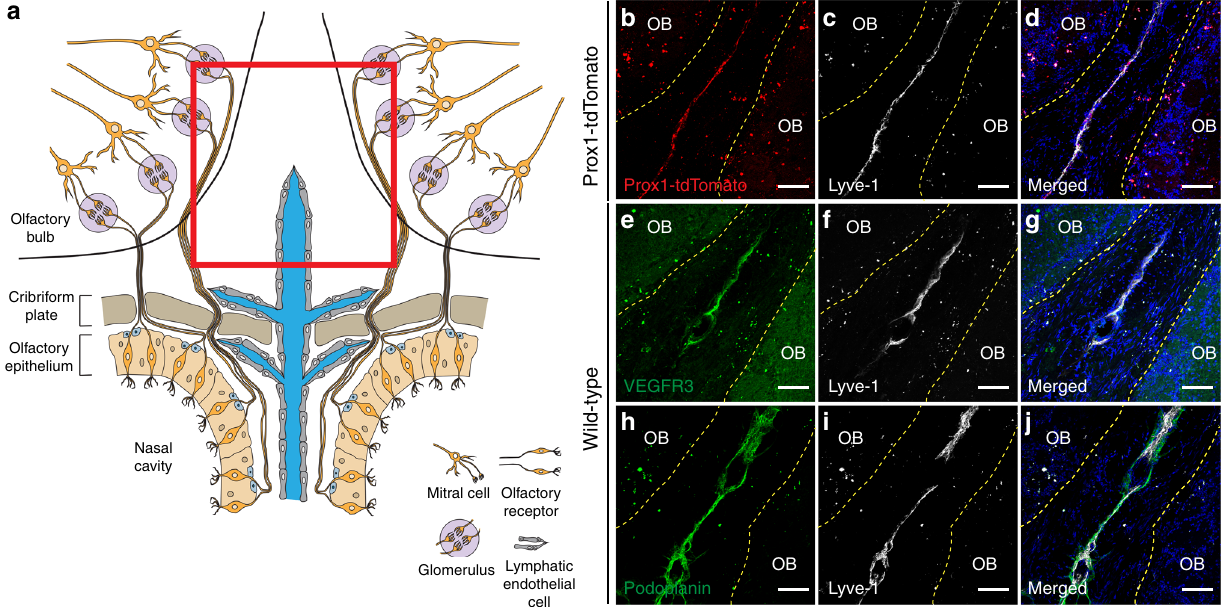
Fig. 1 Cribriform plate lymphatics exist dorsal to the cribriform plate. a Diagram of a coronal section through the olfactory bulbs, cribriform plate, and olfactory epithelium of a mouse. The red inset indicates the region of vessels characterized in b – j . Note that these vessels penetrate from the nasal septum through the cribriform plate and into the subarachnoid space. b – d The whole heads of healthy naive Prox1-tdTomato transgenic mice were decalci fi ed, coronally sectioned, and immunolabeled with the lymphatic hyaluronan receptor Lyve-1 ( c ) and DAPI ( d ). Scale bars = 100 μ m. e – j The whole heads of healthy naive wild-type mice were decalci fi ed, coronally sectioned, and immunolabeled with the lymphangiogenic tyrosine kinase receptor VEGFR3, Lyve-1, and DAPI ( e – g ) or the lymphatic marker Podoplanin, Lyve-1, and DAPI ( h – j ). Scale bars = 100 μ